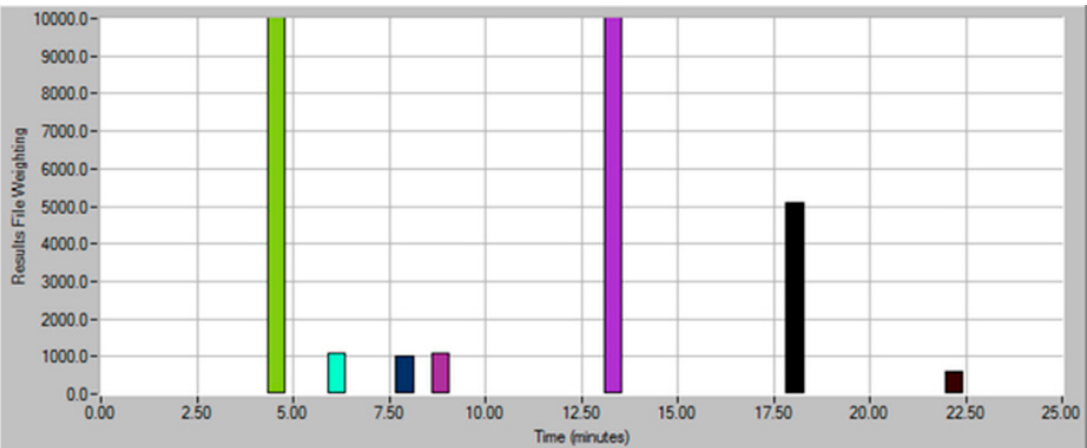
Figure 6. Aroma dilution analysis plot of wine made from Frontenac grapes harvested at 22° Brix. The compounds most impactful in the total aroma of this sample occurred at: (1) 13.3 min, assigned odor dilution number 16; and (2) 18.0 min, assigned odor dilution number 16, while simultaneously identified using a mass spectrometer as: (1) ethyl hexanoate; and (2) ethyl octanoate.